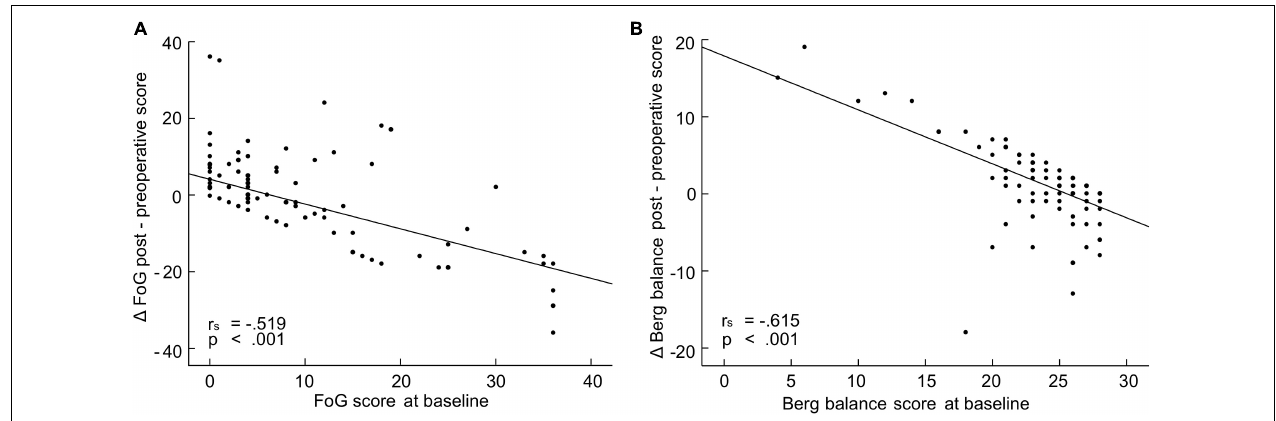
FIGURE 2 | Relation of freezing of gait (FoG) and balance improvement to pre-operative symptom severity. FoG (A) and Berg balance (B) scores as recorded before and after subthalamic nucleus (STN)-deep brain stimulation (DBS) surgery. The pre-operative scores were recorded in the MED OFF condition, the post-operative scores were recorded in STIM ON/MED OFF condition. Values inset of Spearman correlation and best fit lines are given.